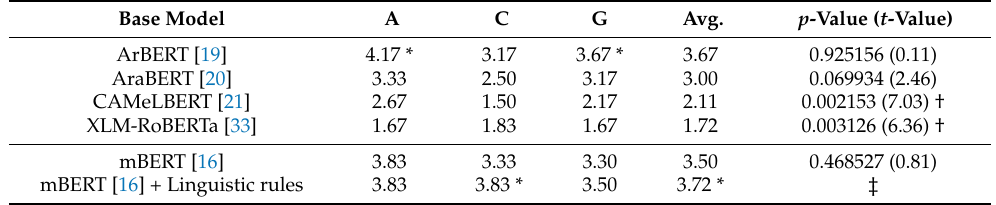
Table 7. Human evaluation results for the three criteria: A dequacy, C ontextual soundness, and G rammaticality. Base pre-trained models with † are significantly different from PDTS’s base model ‡, depending on a two-tailed independent student t -test, at p < 0.05. The asterisk * indicates the best